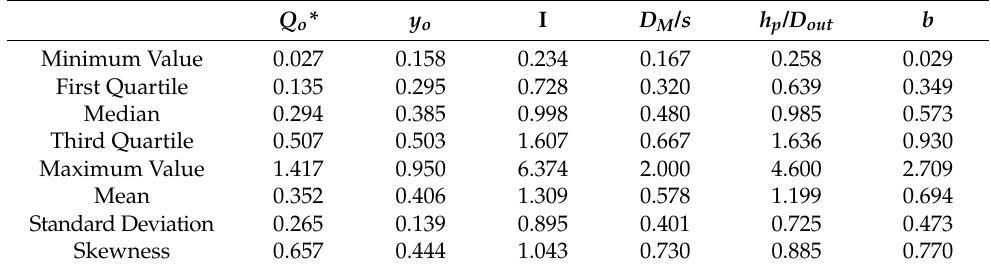
Table 2. Statistical description of the training dataset, with the exclusion of D out / D M .